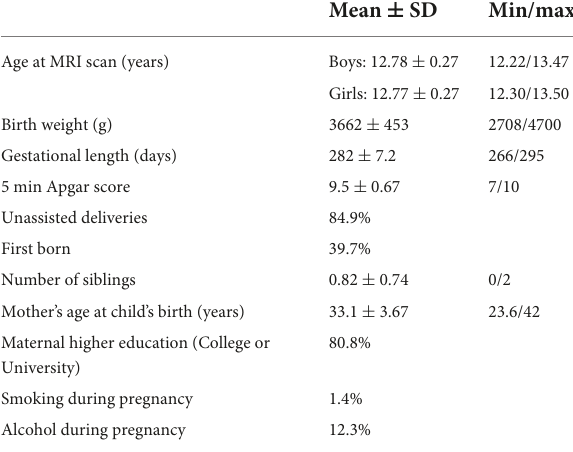
TABLE 1 Descriptive statistics of the mother and